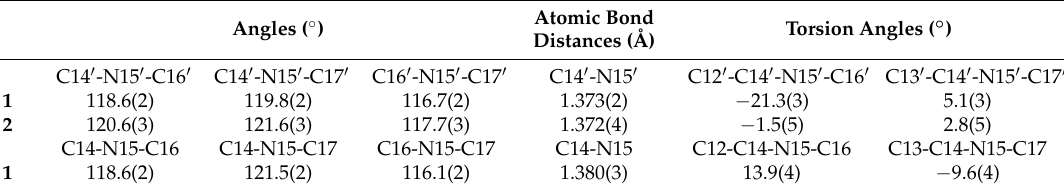
Table 2. Torsion angles, atomic bond distances and angles for the dimethylamino group in compounds 1 and 2 .